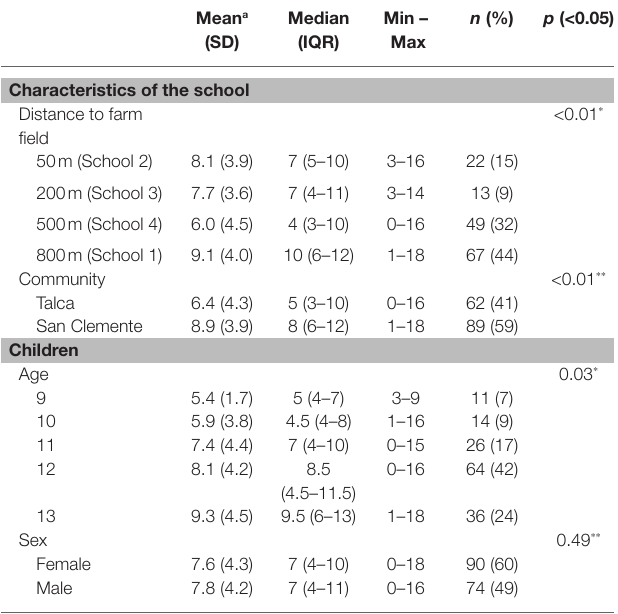
TABLE 2 | Descriptive results of the questionnaire’s total score according to distance from school to farms, school commune, educational level, and sex of the schoolchildren.